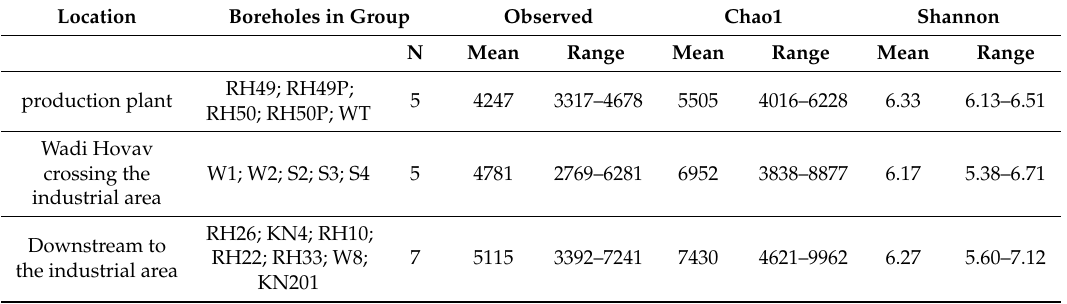
Table 4. Mean values of the Observed, Chao1 and Shannon diversity indices for each area in the industrial